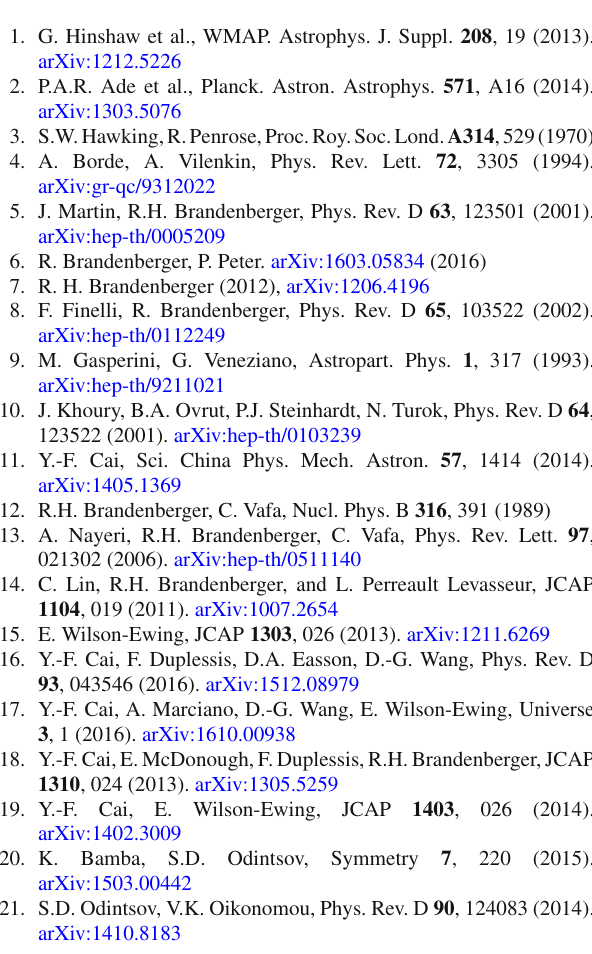
tracting phase) and w = w cr = − 0 . 003 provided that ρ (cid:3) > 0 even at the bounce point ( H = 0)